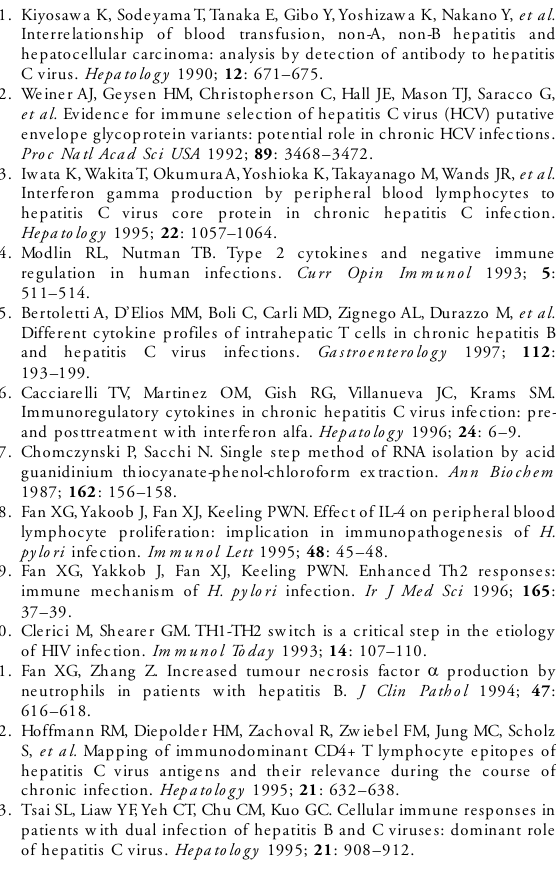
ALT: alanine transaminase, no significance difference in each